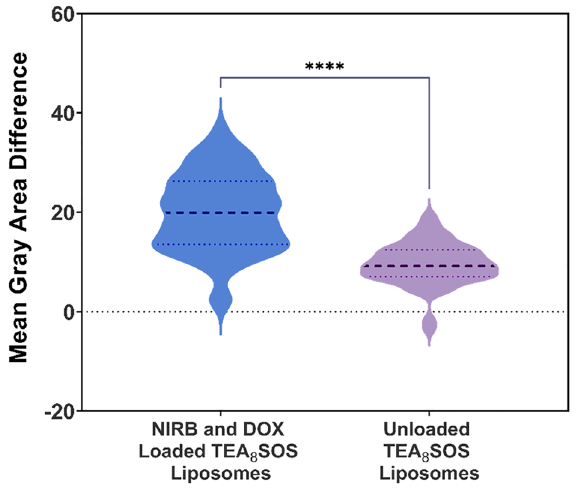
Figure 7. Differences in mean gray area of the exterior versus interior of drug loaded (NIRB-DOX-FA) and unloaded TEA 8 SOS liposomes. Mean gray area is defined as the average photo intensity divided by the number of pixels in a selected image area. Mean gray area was determined to quantify the darkened electron dense areas at the core of NIRB-DOX-FA liposomes versus unloaded liposomes. As such, statistically significant differences in mean gray area across the bilayer of NIRB-DOX-FA liposomes, relative to unloaded liposomes, highlights the presence of electron dense drug deposits after active drug loading. Mean gray area of the liposomes was determined by ImageJ software for the cryo-TEM images. Data is presented as differences in mean gray area (n = 56 liposomes, ****p <